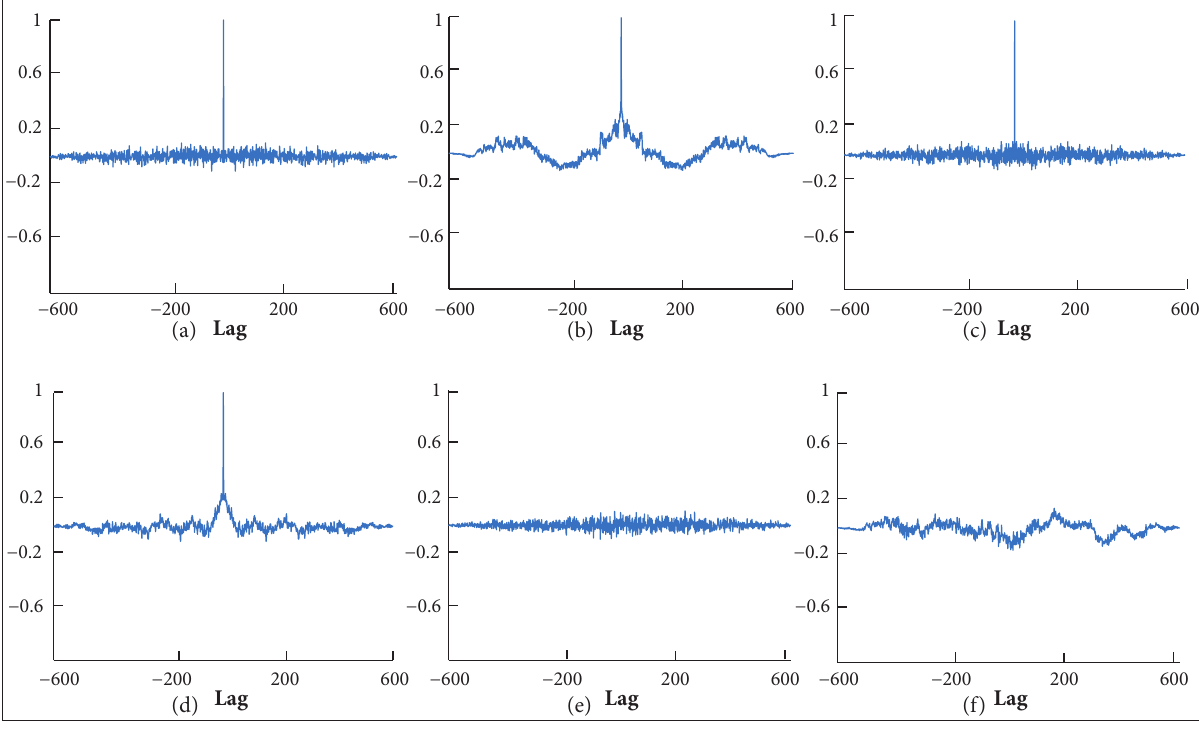
Figure 8. (a) Normalized autocorrelation of simulated radar distance noise; (b) Normalized autocorrelation of real radar distance noise; (c) Normalized autocorrelation of simulated radar azimuth noise; (d) Normalized autocorrelation of real radar azimuth noise; (e) Normalized cross-correlation of simulated radar noise; (f) Normalized cross-correlation of real radar noise. (range) and azimuth are uncorrelated (Fig. 8e), as it is usually assumed (Bar-Shalom et al.